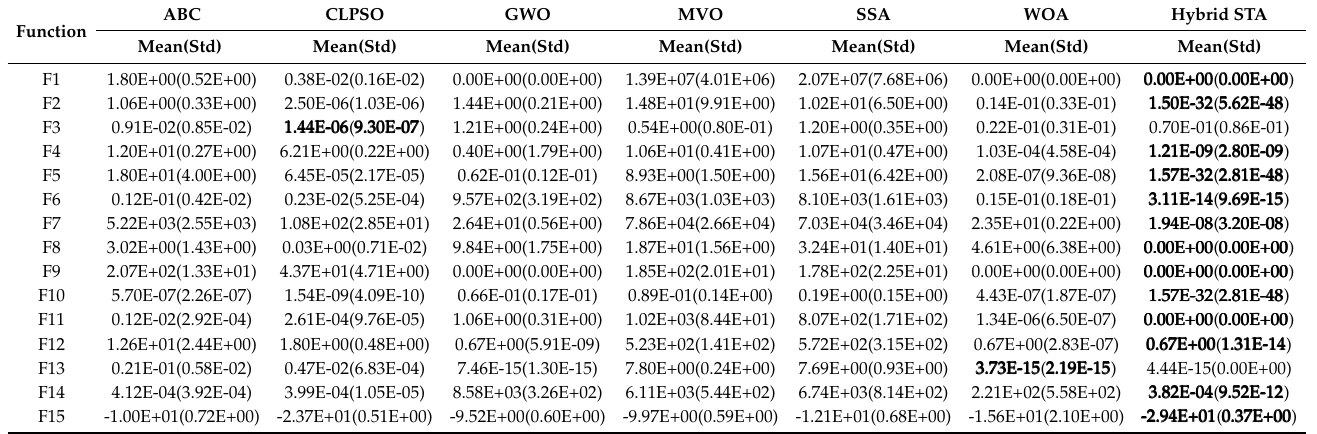
Table 4. Statistical results for different metaheuristic methods with D =